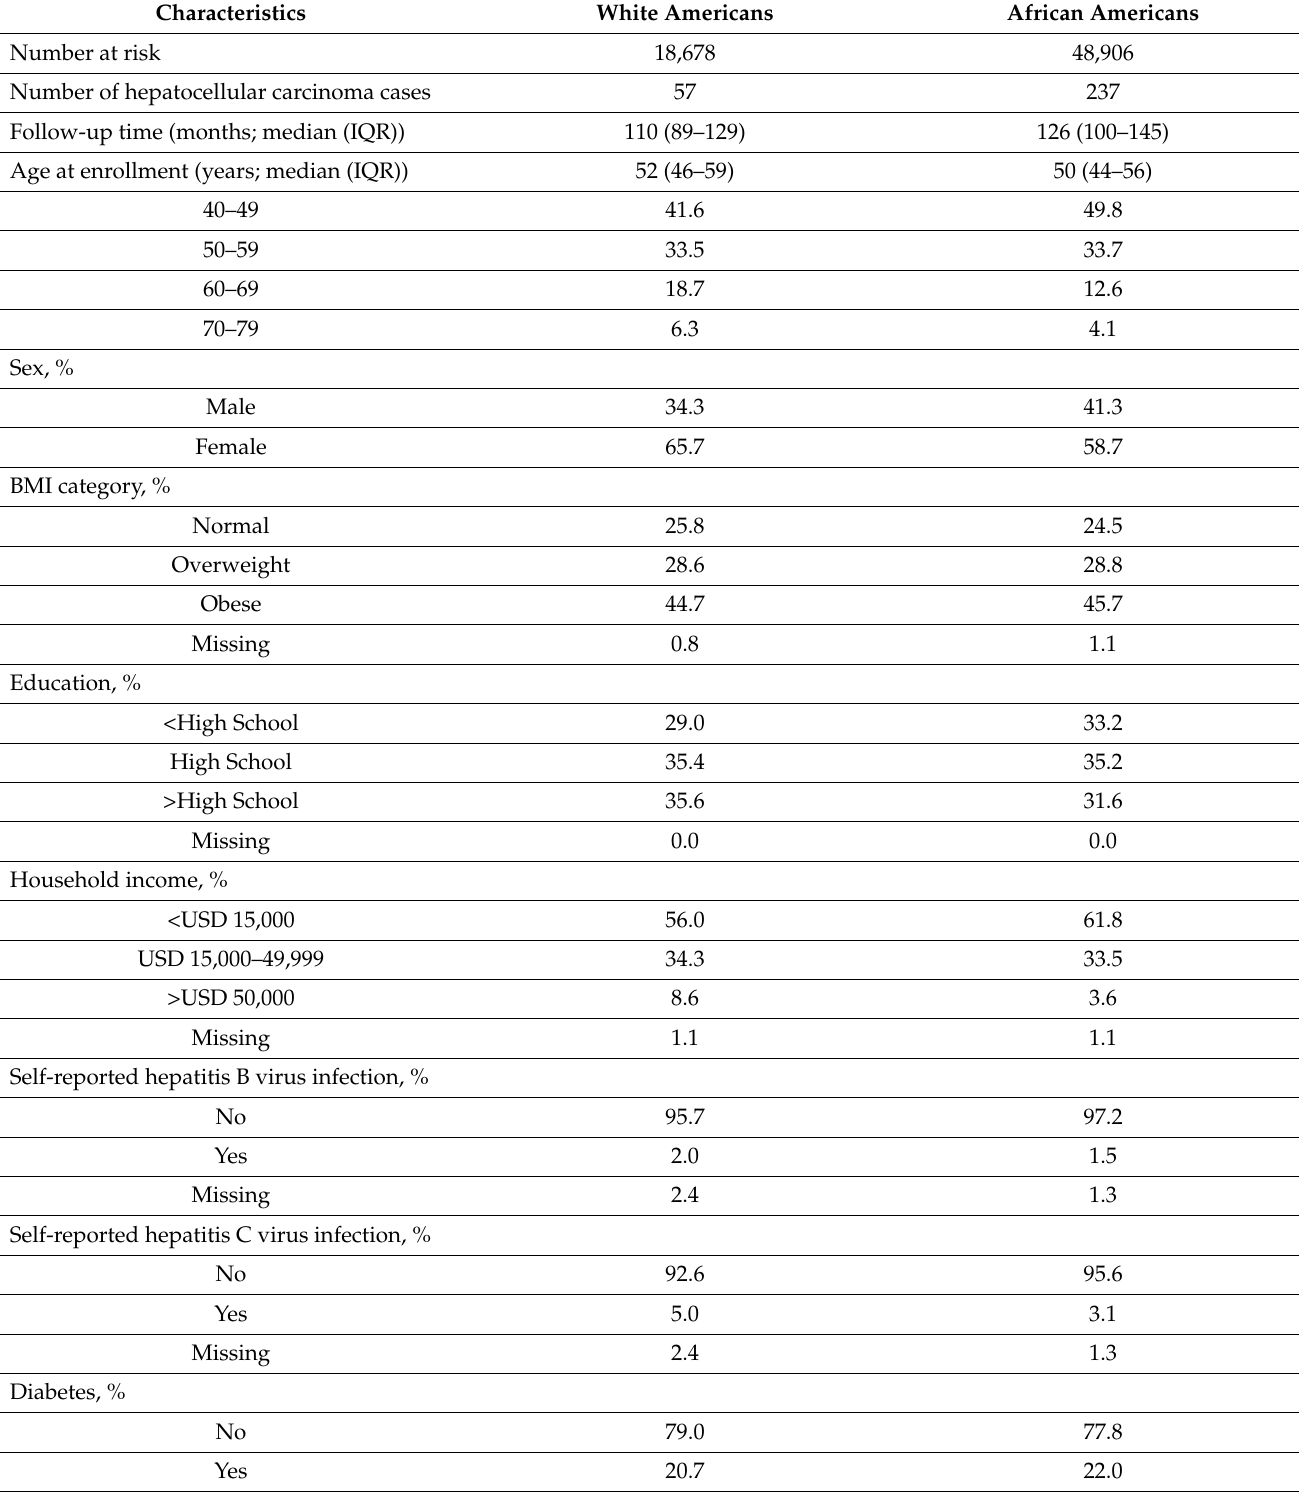
Table 1. Baseline characteristics of the study population by